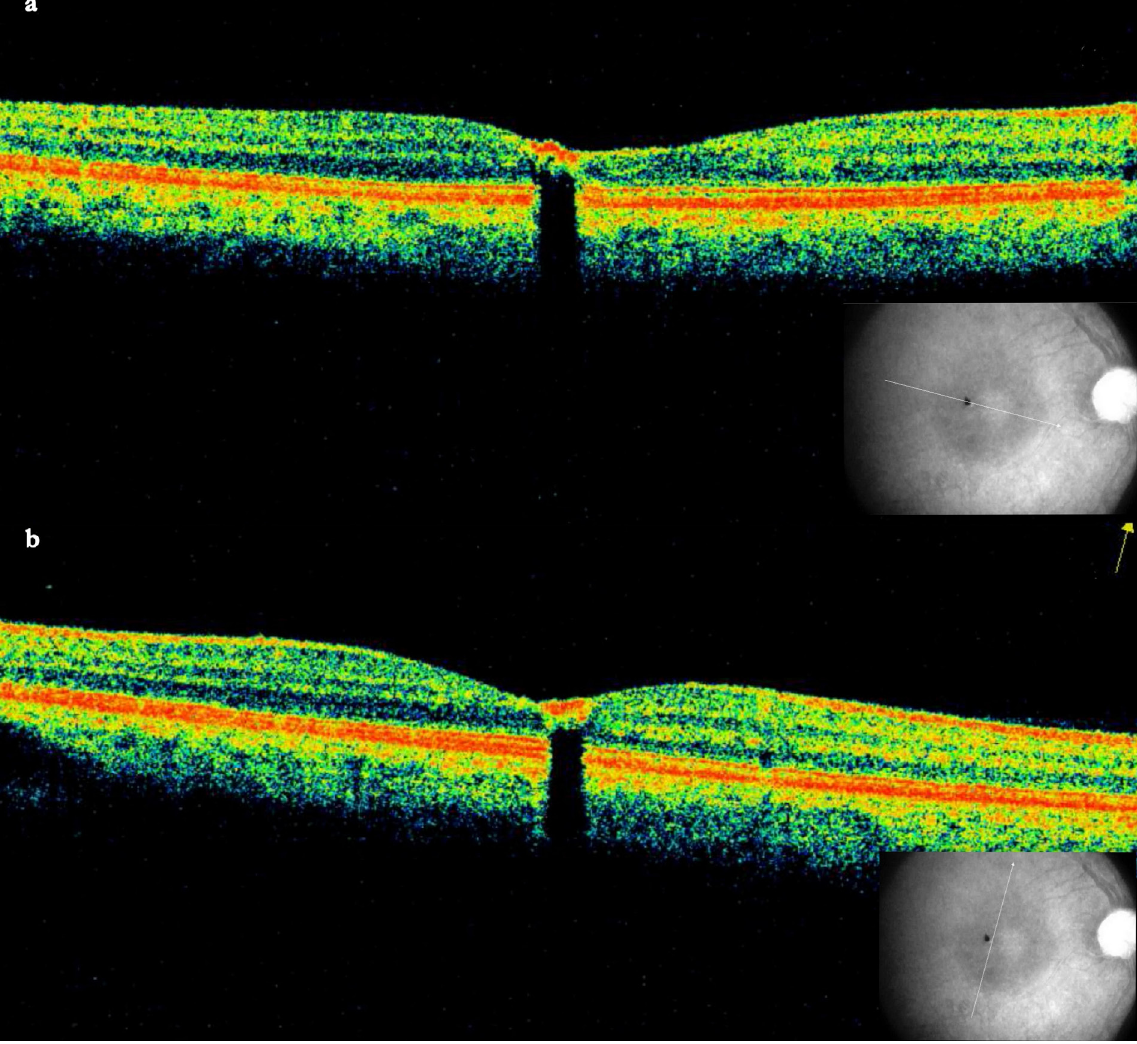
Figure 2: a) The OCT scan through the lesion, shows a hyperreflective lesion at the surface with shadow effect. b) The OCT scan through the depigmented margin shows surface lesion with shadow